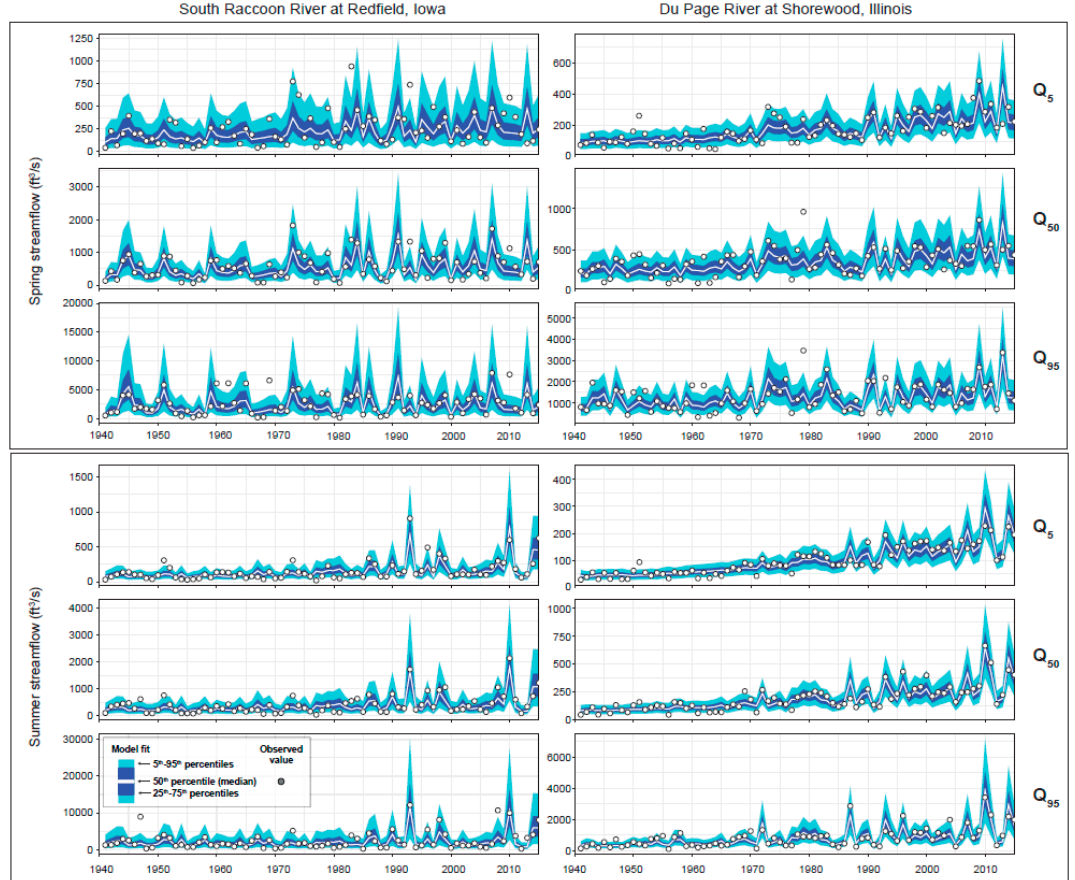
Figure 4. Time series illustrating probabilistic model fits at two sites (1940–2015): model P . PA at the South Raccoon River at Redfield, Iowa (site 05484000), and model P . Ppop at the Du Page River at Shorewood, Illinois (site 05540500). Two seasons are shown: spring ( top ); and summer ( bottom ). Within each panel, the rows correspond to three streamflow quantiles: low flow ( Q 0.05 ), median flow ( Q 0.5 ) and high flow ( Q 0.95 ). The fitted distribution is shown in three colors: a pale blue ribbon (5th–95th percentiles), a dark blue ribbon (25th–75th percentiles), and a white line passing through the middle (50th percentile). The white-filled circles indicate the observed values. For time series of model fits at all other sites, see Figure S2.